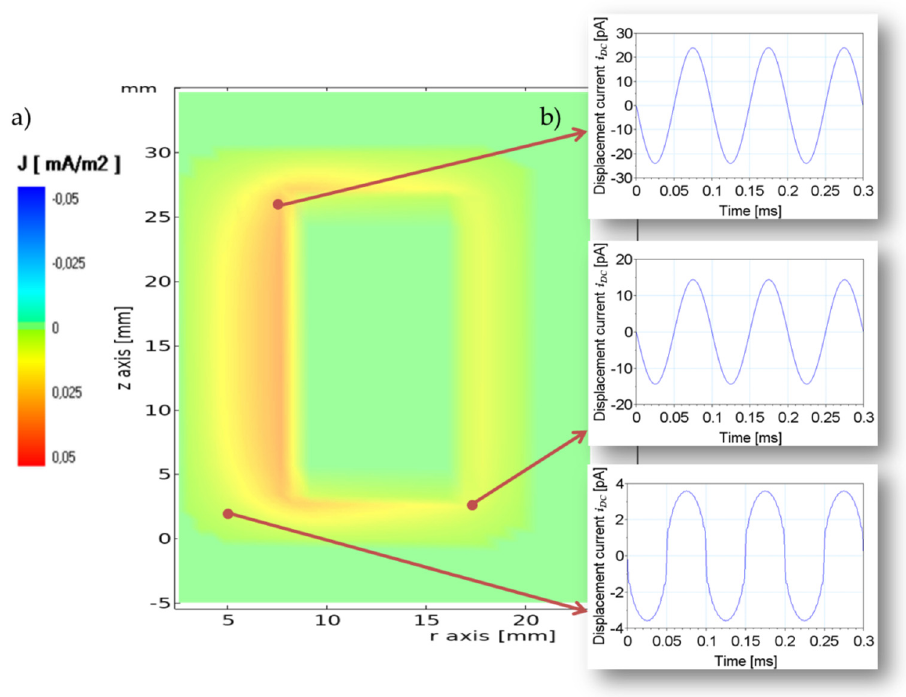
Figure 12. Distribution of the displacement current density in the ferrite core for time t = 70 us ( a ) and the waveforms of the displacement currents i DC for three selected points of ferrite core ( b ) for a frequency of 1 kHz.